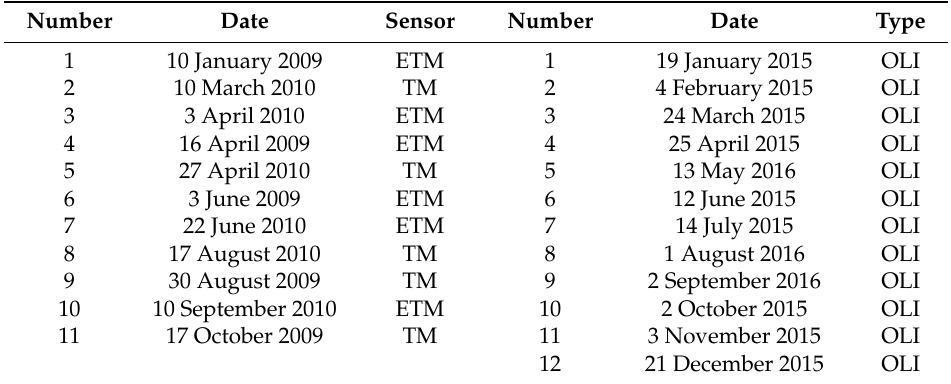
Table 1. Description of Landsat images (including Thematic Mapper (TM), Enhanced Thematic Mapper Plus (ETM+), and Operational Land Imager (OLI) image) used in the